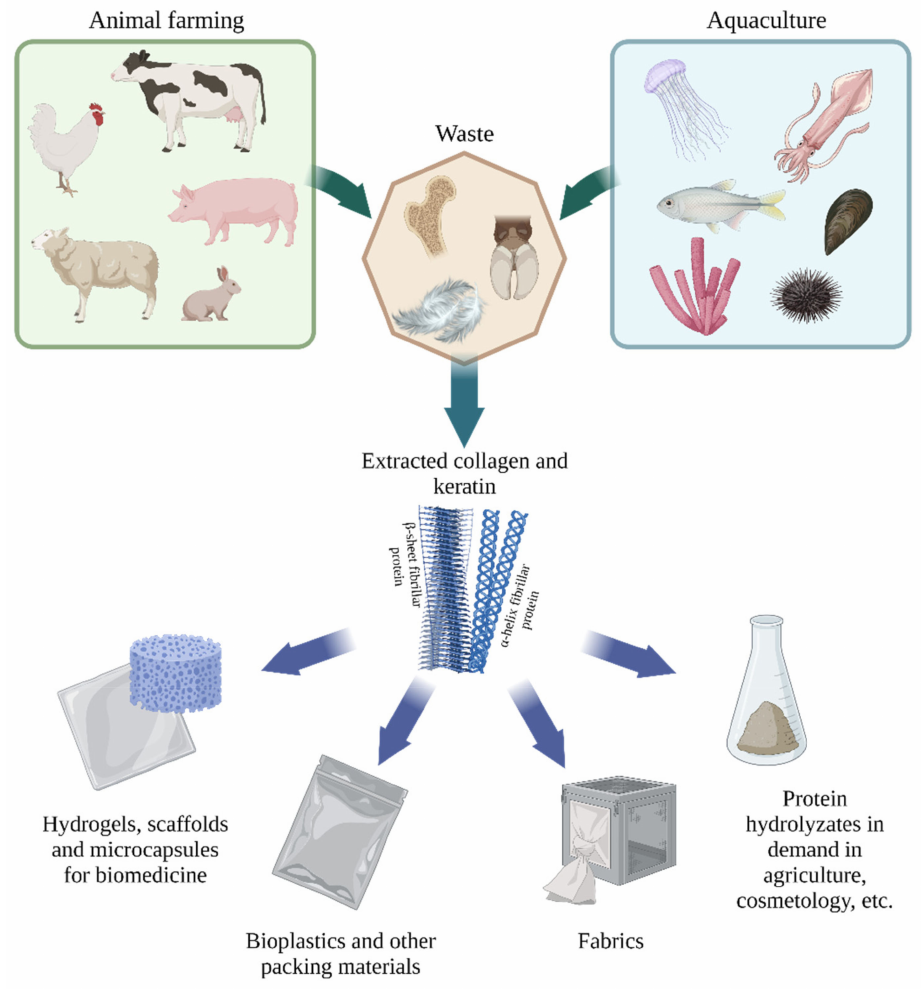
Figure 1. Sources and applications of collagen and keratin (created with BioRender.com, access date: 9 November